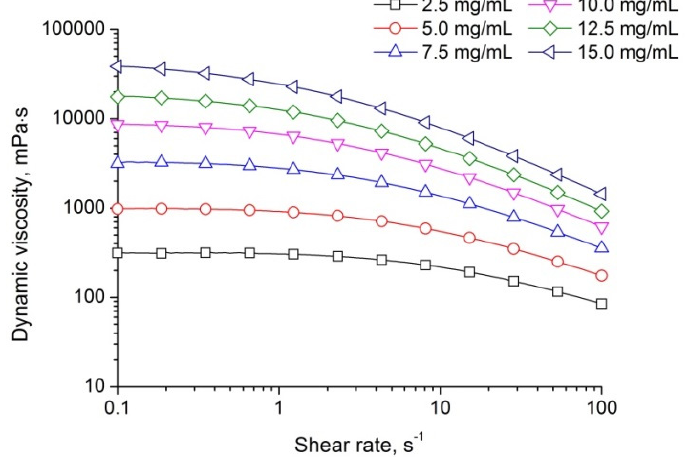
Figure 6. Dynamic viscosity of hyaluronic acid solutions as a function of shear rate and polymer concentration at 25.0 ± 0.2 °C.